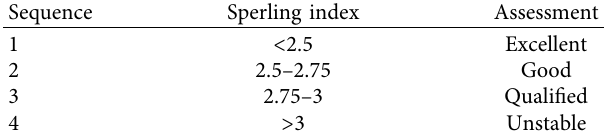
Table 2: China’s vehicle running Sperling index and grade.